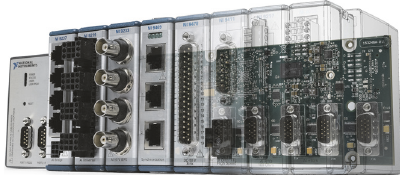
Figure 3: Industrial controller, NI CompactRio [retrieved on June